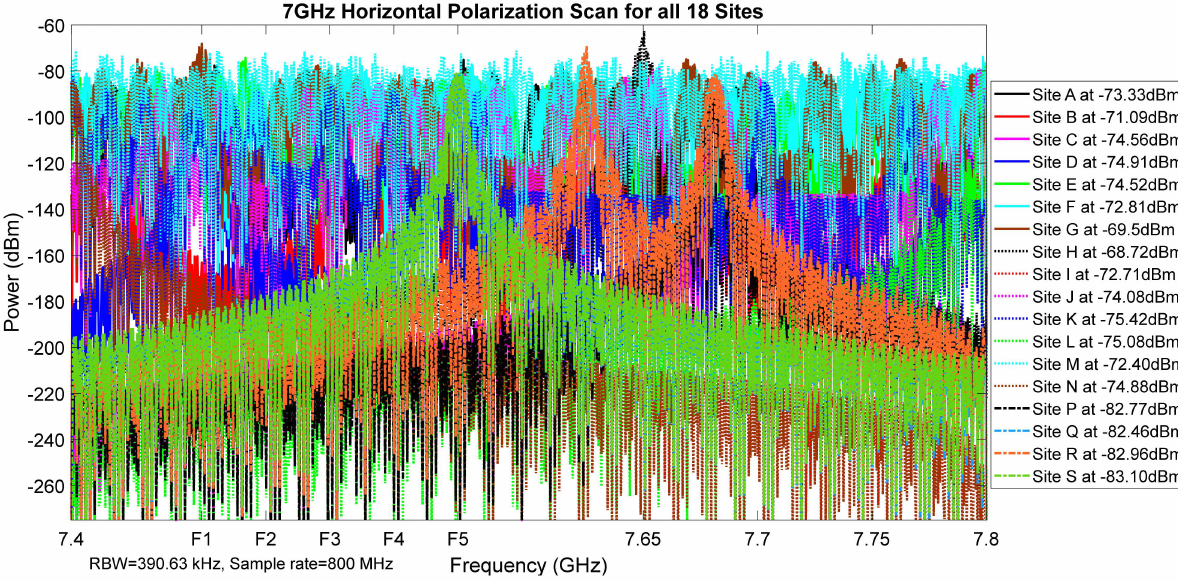
Figure 43. The 7 GHz horizontal polarization scan for all sites after denoising and applying the algorithm to all sites, including those without the potential to cause